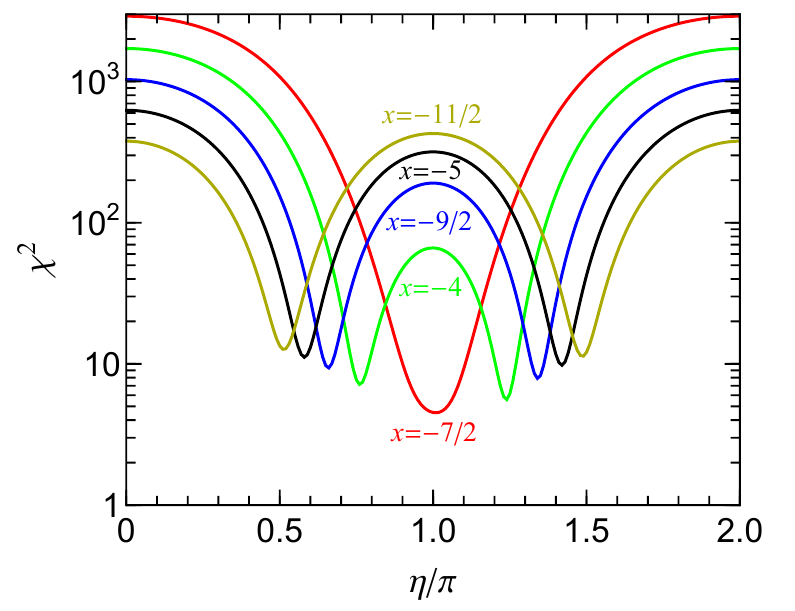
Figure 4 . Variation of (cid:31) 2 with respect to the phase (cid:17) for the typical values of x = (cid:0) 7 = 2, (cid:0) 4, (cid:0) 9 = 2, (cid:0) 5, (cid:0) 11 =